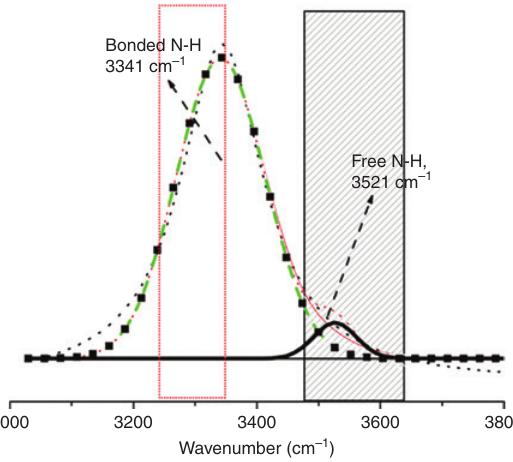
Figure 7: Representative deconvolution curve showing N-H zone for WPUDCO-1 polyurethane